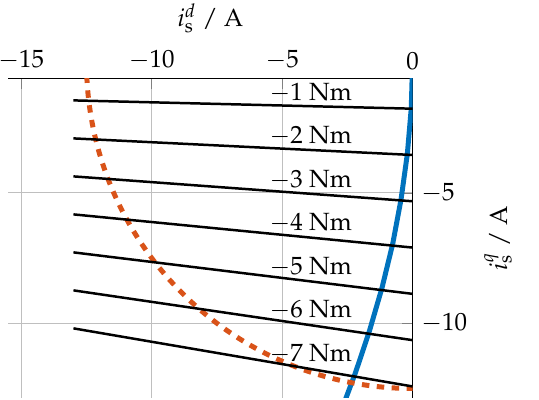
Figure 3. Illustration of the torque contour lines ( ), the current limit ( ), and the numerically calculated Maximum Torque per Current (MTPC) hyperbola with linearised flux linkages ( ). The black lines are the contour lines calculated with (10), where the torque is constant for each line. The blue line represents the MTPC hyperbola, which connects the points with the minimum current amplitude of each contour line. The dashed red line is the current limitation, given by